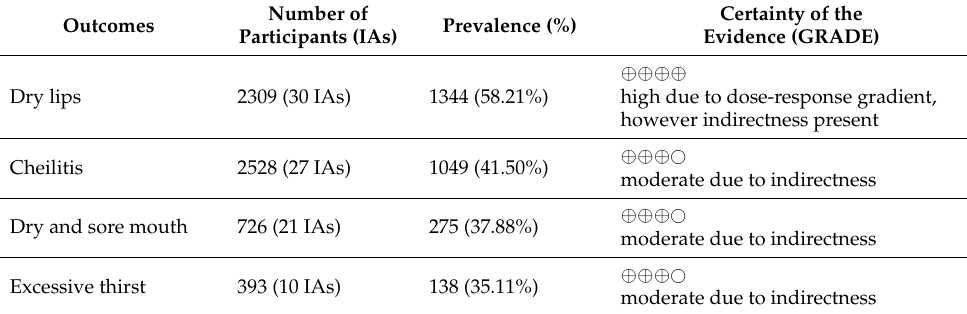
Table 6. Summary of ISO therapy adverse events: oral